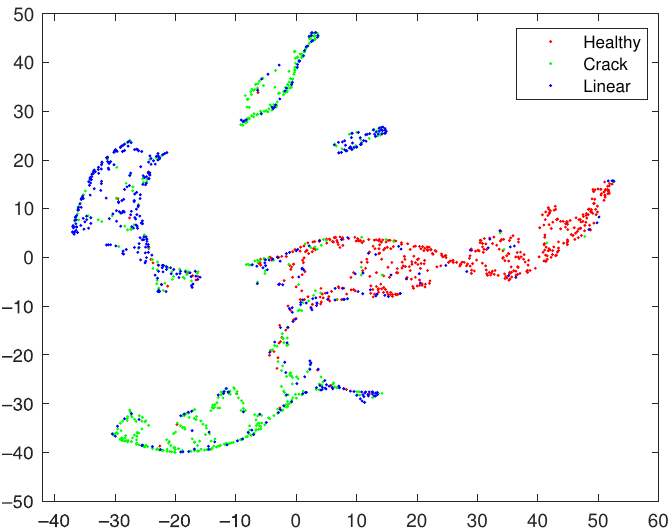
Figure 17. t-DSNE visualization of the samples composed by the deterministically extracted